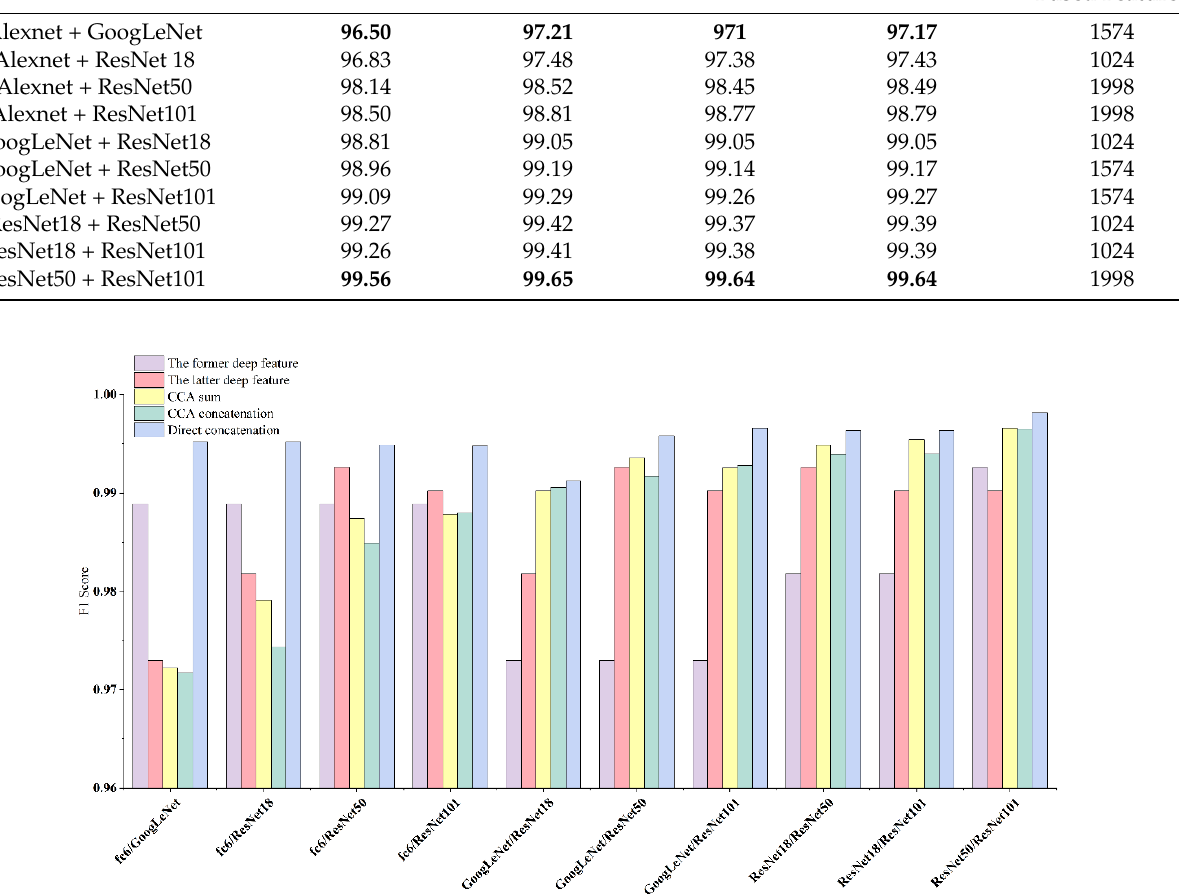
Figure 4. Performance comparison of single deep feature and fusion deep features.